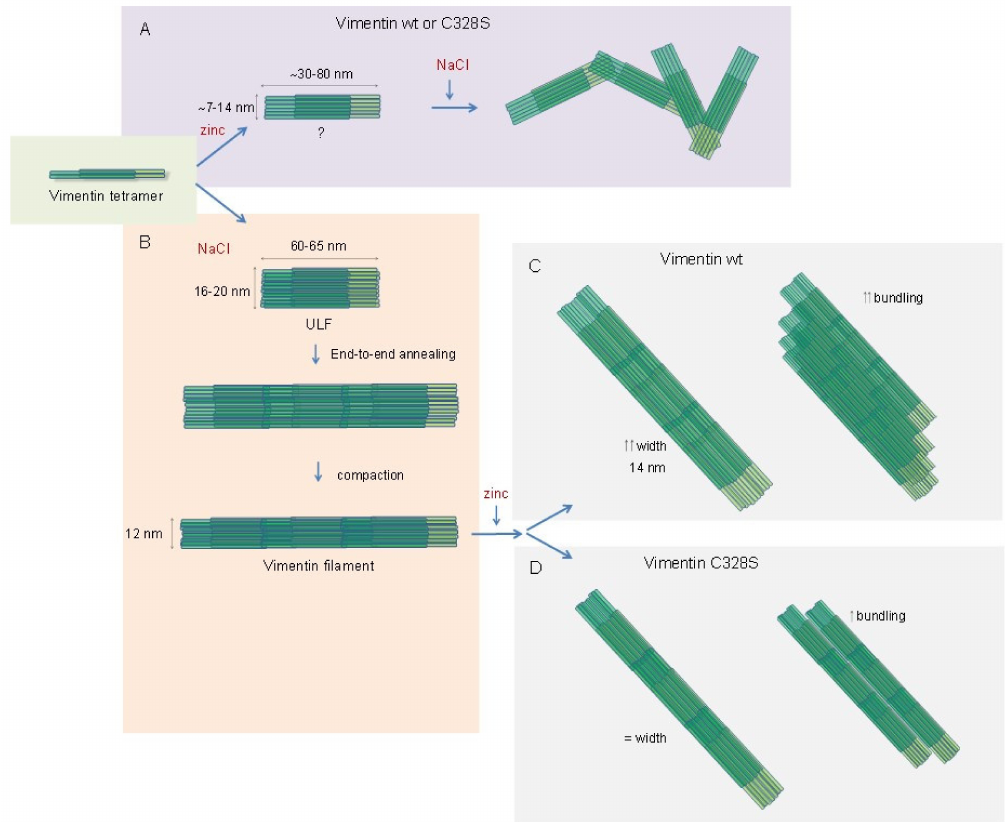
Figure 7. Scheme summarizing the impact of zinc on vimentin assembly as monitored by electron microscopy. Soluble vimentin, represented by a vimentin tetramer, forms atypical structures when incubated with ZnCl 2 ( A ). Subsequent addition of NaCl does not produce filaments, but entangled aggregates. This e ff ect is similar for vimentin wt and C328S. Conversely, incubation of soluble vimentin with NaCl ( B ) elicits the typical polymerization process, characterized by the formation of unit length filaments (ULF) and end-to-end annealing of these structures that are further compacted to form mature filaments. Incubation of these preformed filaments with zinc leads to a marked increase in width and intense bundling in the case of vimentin wt ( C ), whereas C328S mutant filaments do not su ff er changes in width and undergo less intense bundling ( D